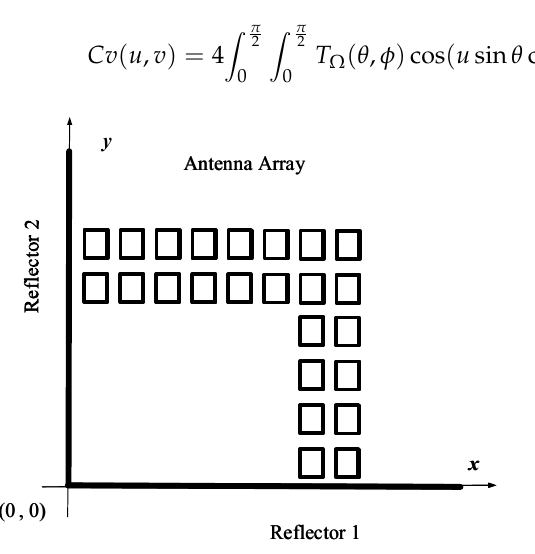
Figure 6. Illustration of 2-D MAS.